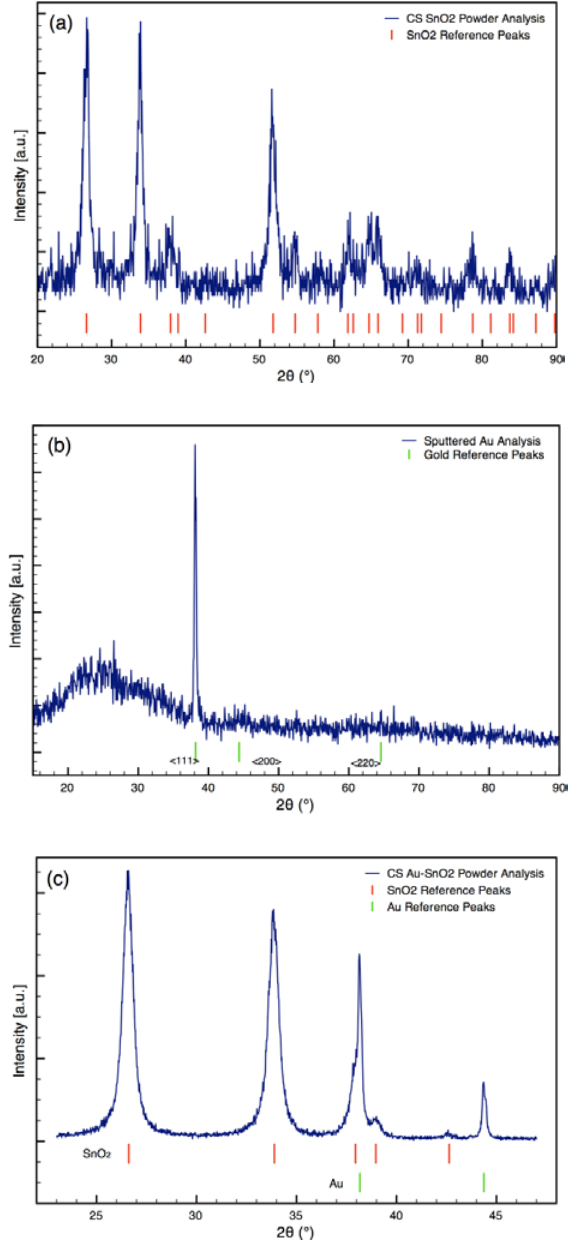
Figure 3. Comparison of typical XRD spectra of (a) undoped SnO (post heat treatment) Au film on glass substrate, Sensor C outermost layer and (c) CS Au-doped SnO film, Sensor A film & D outermost layer (typical high resolution XRD 2 spectrum used for Scherrer